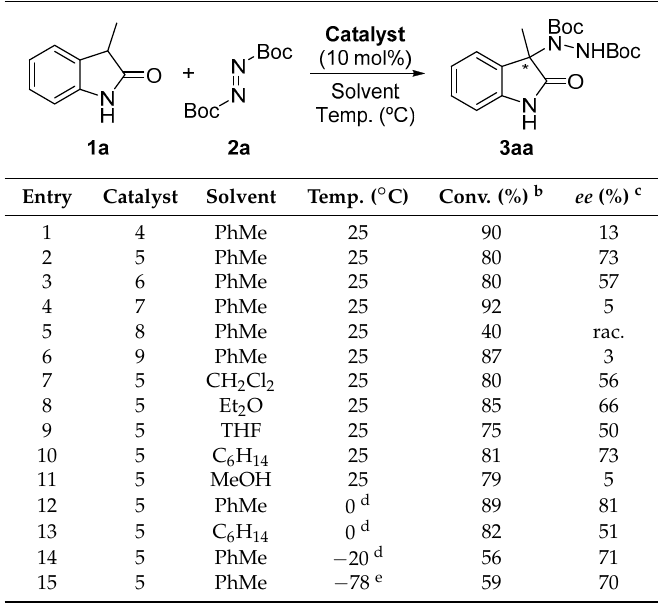
Figure 2. Benzimidazole-derived organocatalysts